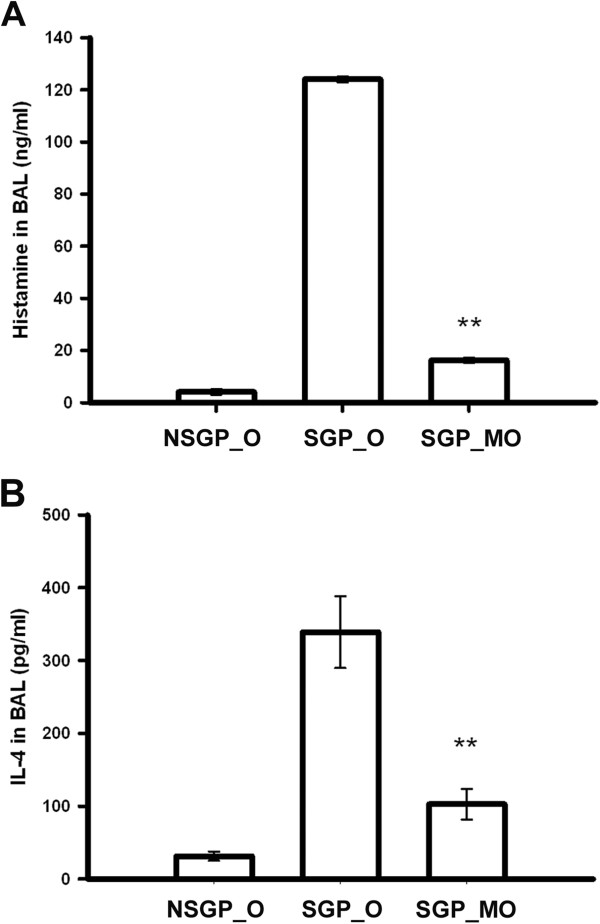
Effect of the CTCM on the histamine and IL-4 levels in the BALF. CTCM treatment before OVA challenge reduced the histamine and IL-4 levels in the BALF 5 min after OVA challenge (one-way ANOVA with a Duncan post-hoc test, **P <0.01: SGP_MO vs. SGP_O). Each group represents the mean of the data from 10 animals and the vertical bars represent the standard deviation. (A) Histamine and (B) IL-4. NSGP_O: unsensitized guinea pigs challenged with OVA by nebulization; SGP_O: sensitized guinea pigs challenged with OVA by nebulization; SGP_MO: sensitized guinea pigs treated with 0.06 g/ml nebulized CTCM for 5 min, followed by OVA challenge by nebulization (at 5 min post-CTCM nebulization).